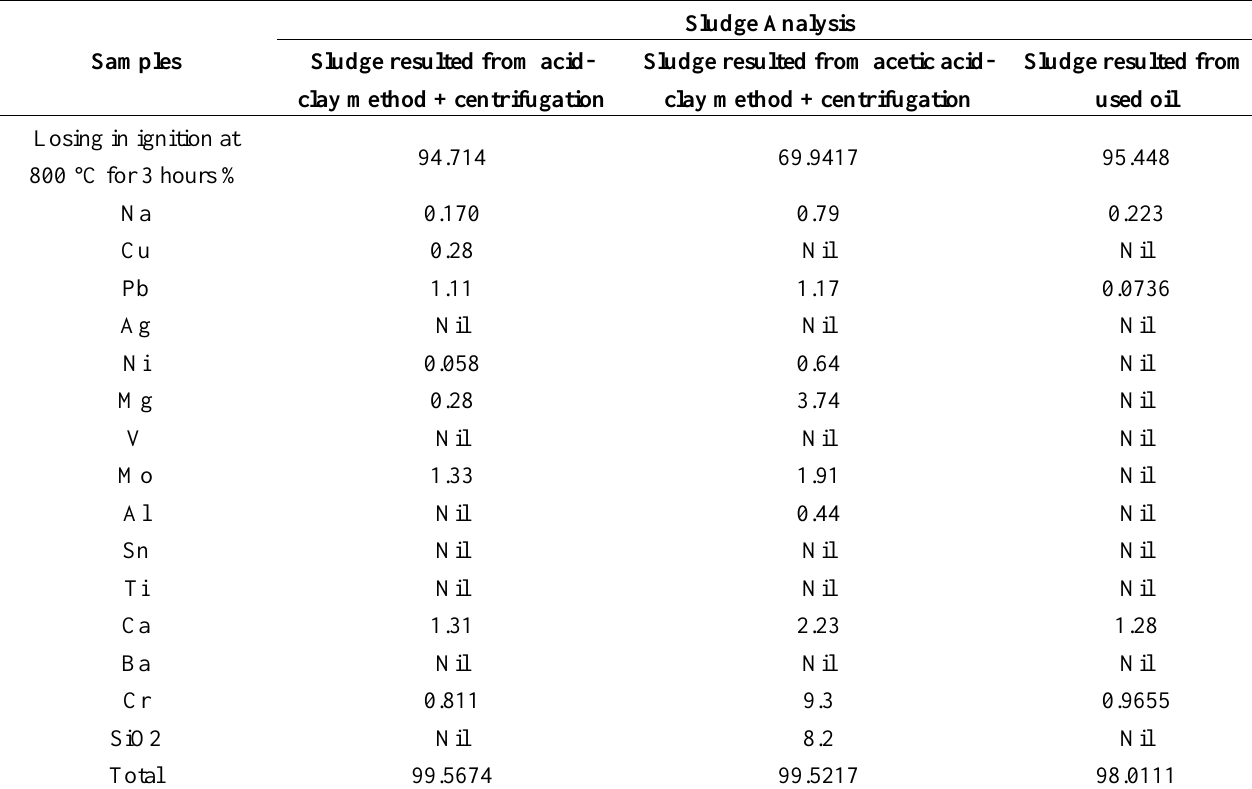
Table 6. Analysis results of the sludge.